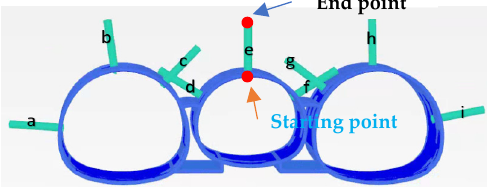
Figure 22. Schematic diagram of the locations of rock bolts.